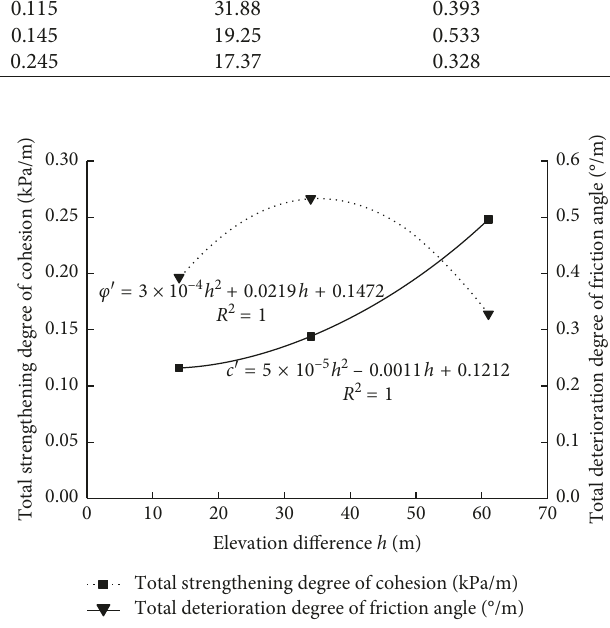
Figure 15: Evolution curve of shear strength parameters with elevation